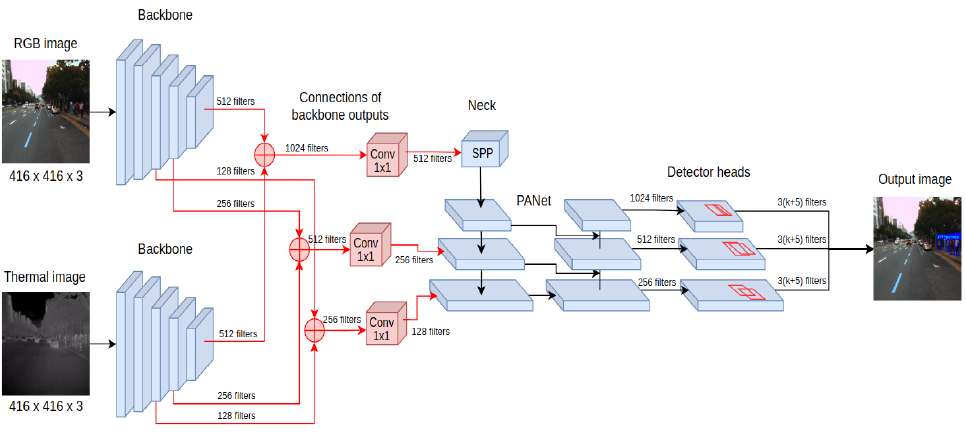
Figure 5. The processing pipeline of the YOLO4-Middle detector architecture extracts independent features for RGB and thermal inputs that are combined on different processing levels before the layers responsible for object